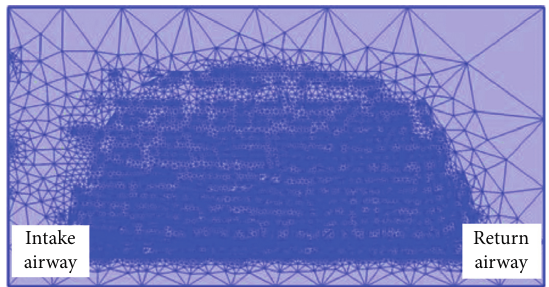
Figure 8: Network partition diagram of mining fracture field